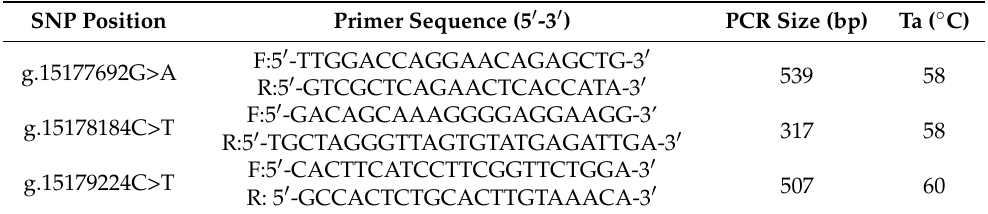
Table 1. Primer sequences used for single nucleotide polymorphisms (SNPs) validation. SNP